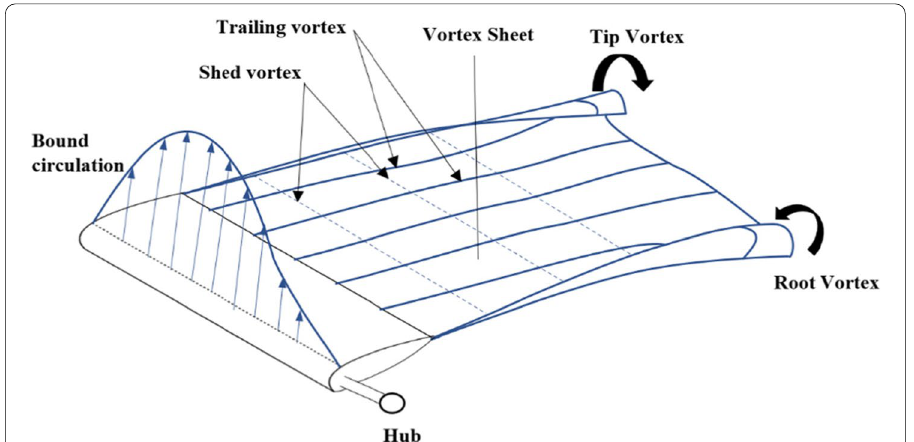
Fig. 3 Rotor wake model using free-wake method